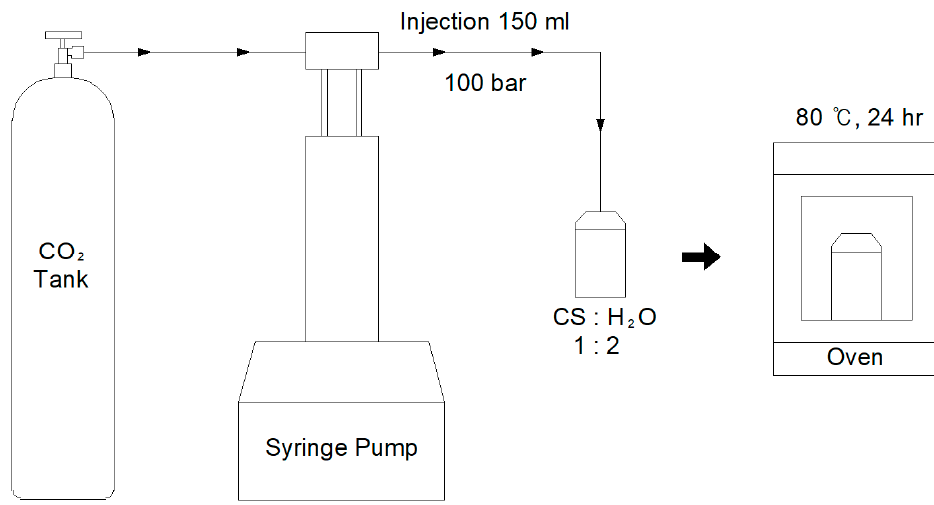
Figure 2. Experimental setup for reaction between converter slag and supercritical CO 2 . CS in figure indicates converter slag.